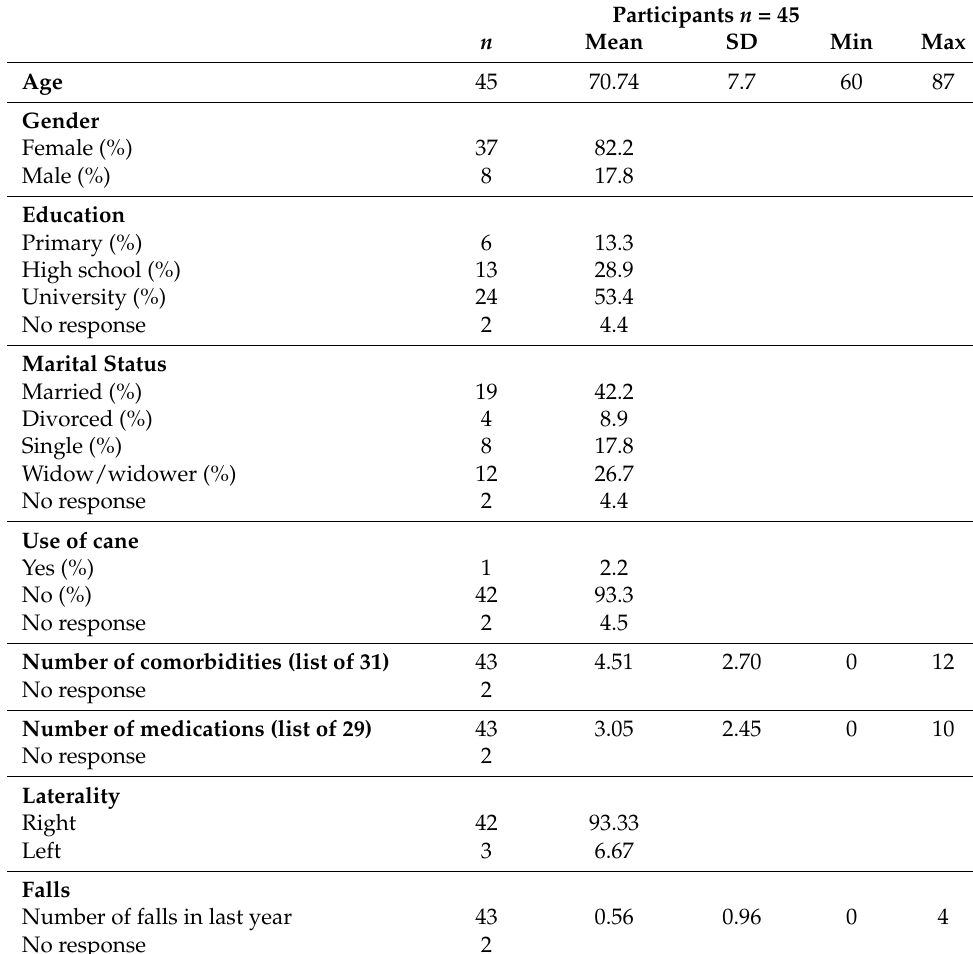
Table 1. Sociodemographic characteristics of intervention group participants who completed the structured multicomponent physical exercise